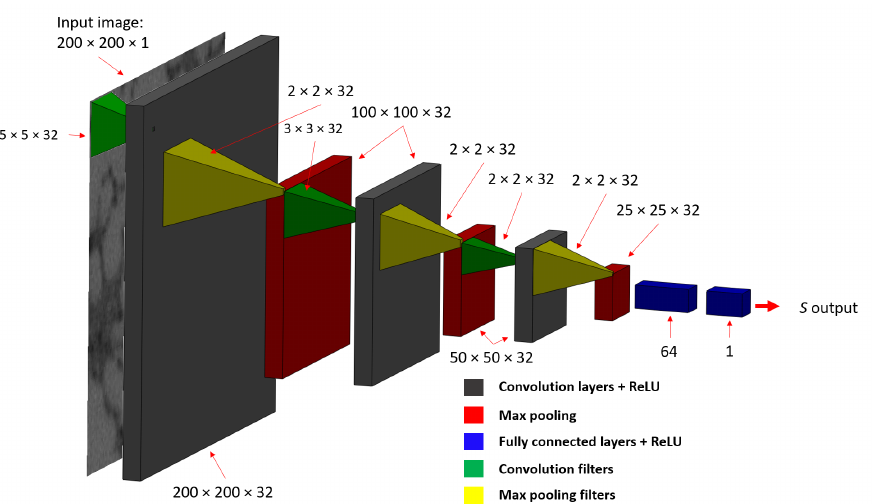
Figure 6. The CNN architecture used for estimating SDAS directly from microstructure image